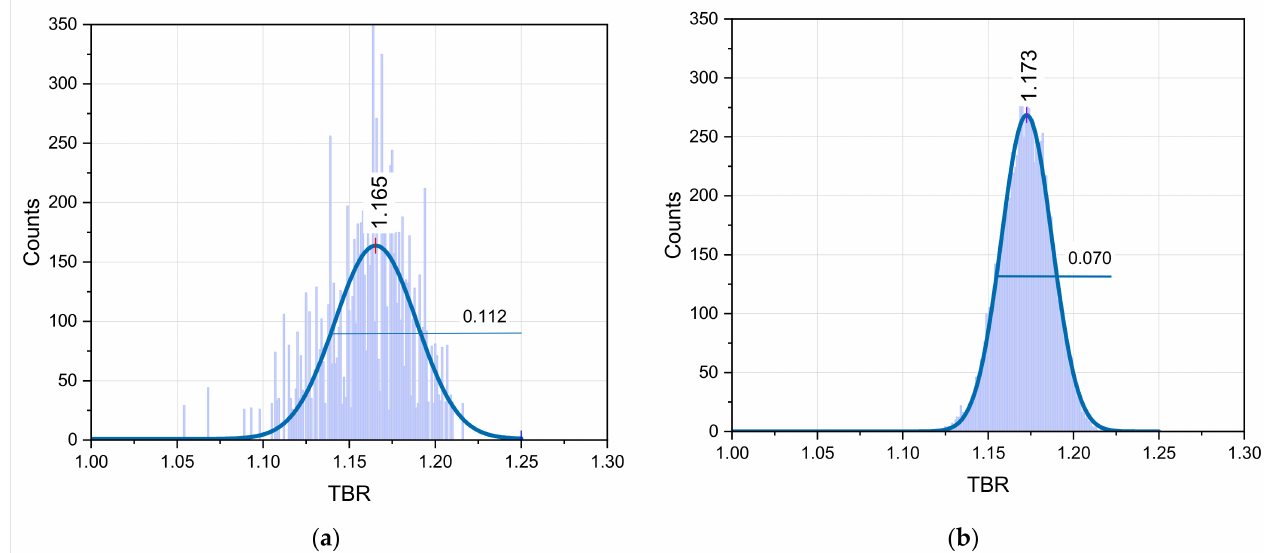
Figure 10. The TBR statistical distribution for the variated n+ 56 Fe data from TENDL-2017 library ( a ) and TBR distribution for the TENDL-2017 data and 300 random files for n+ 56 Fe from JEFF-3.2 ( b